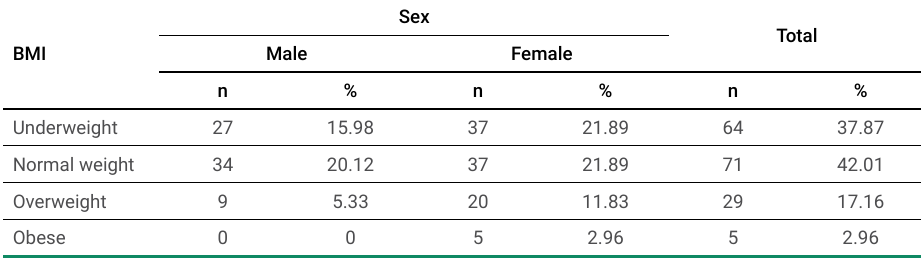
Table 2. Body mass index of the inhabitants of native communities, according to sex.